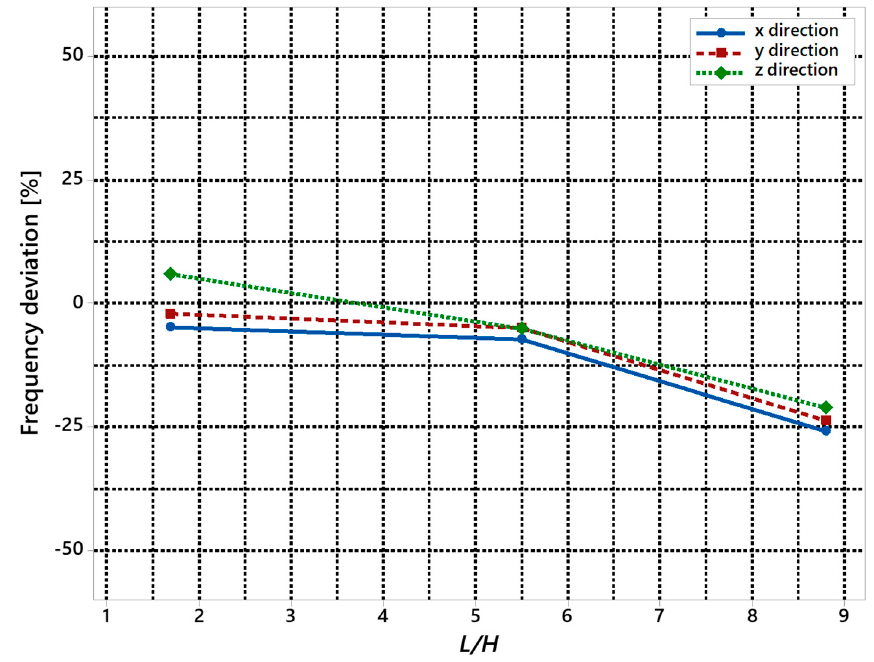
Figure 12. Translational frequency deviation [%] at different values of L/H .